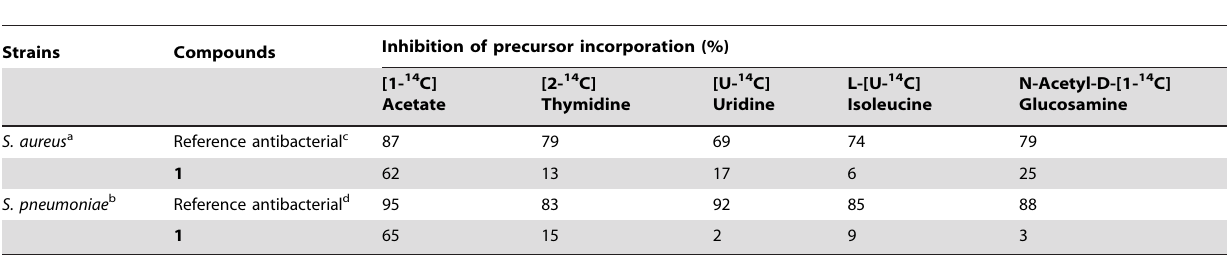
Table 4. Effects of meleagrin ( 1 ) on incorporation of radiolabeled precursors into S. aureus and S. pneumoniae .